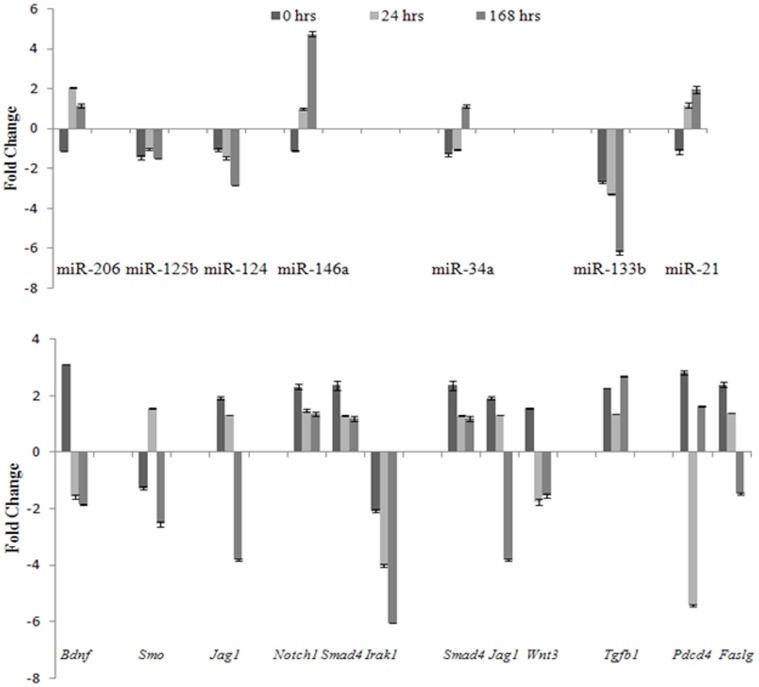
Comparison of miRNA expression with its corresponding mRNA targets measured by quantitative RT-PCR.Data presented as mean ± SEM (n = 3). Target relationship: miR-206/Bdnf; miR-125b-5p/Smo; miR-124/Jag1; miR-146a/Notch1, Smad4 and Irak1; miR-34a/Smad4, Jag1 and Wnt3; miR-133b/Tgfb1; miR-21/Pdcd4 and Faslg.